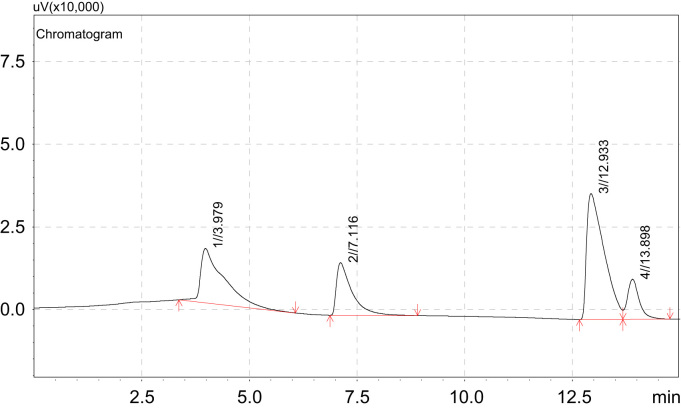
Sample standard.